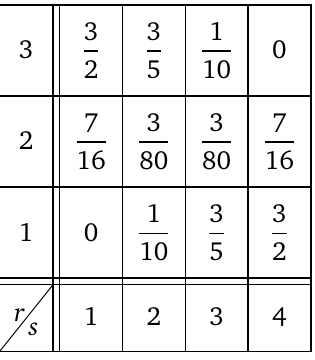
Table 3.1: The Kac table of the conformal dimensions of the TIM, labeled by indices 1 ≤ r ≤ 3 and 1 ≤ s ≤